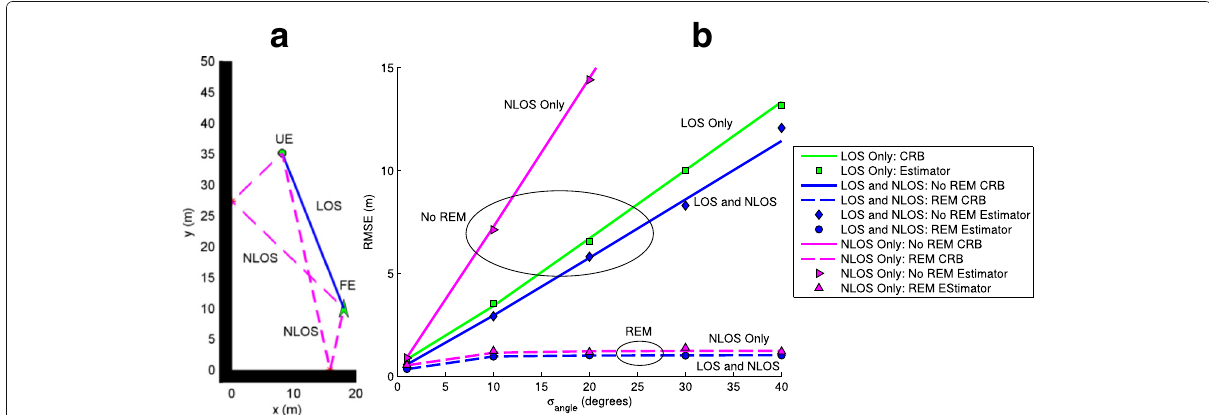
Fig. 5 a Urban corner with one FE, one LOS path, and two NLOS paths. b RMSE curves for all path combinations with and without REM for increasing